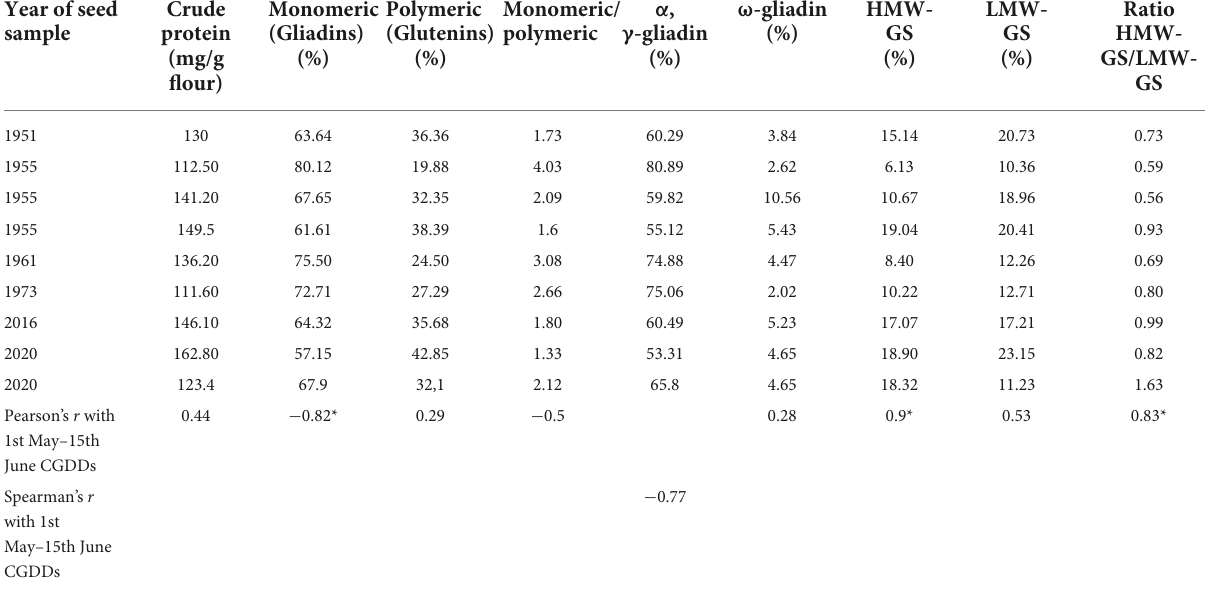
TABLE 2 Amount of crude protein (mg/g flour), protein distribution among fractions (%), and ratio between gliadins/glutenins and HMW-GS/LMW-GS in wheat flours derived from kernels harvested in different